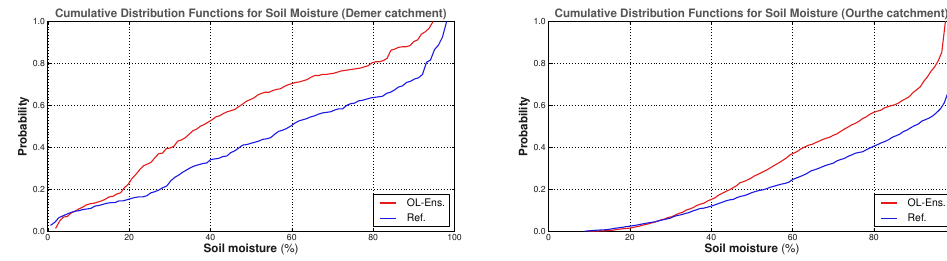
Figure 5. Cumulative distribution functions for surface soil moisture based on spatially averaged open loop and reference data for the period 2010–2015. The CDFs can be used to measure the difference between the OL average and the reference soil moisture values at an equal probability. This leads to the soil moisture bias estimates (red lines) displayed in Figure 6, to which, we fitted a polynomial in order to allow for the calculation of a bias correction for any SSM value. In this case, the polynomial was of degree four for both catchments (blue lines in Figure